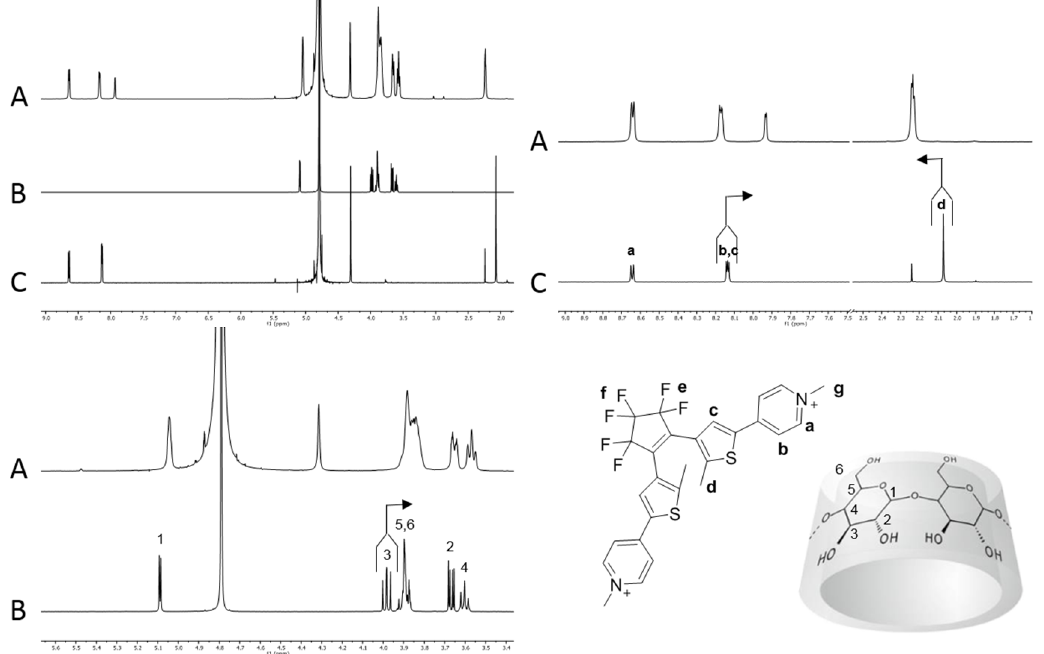
Figure 1. Host–guest interaction between β -CD and photochrome 1o . ( A ) 1o (7.00 ∙ 10 − 3 M) + β -CD (7.00 ∙ 10 − 3 M) in D 2 O; ( B ) β -CD (7.00 ∙ 10 − 3 M) in D 2 O; ( C ) 1o (7.00 ∙ 10 − 3 M) in D 2 O.